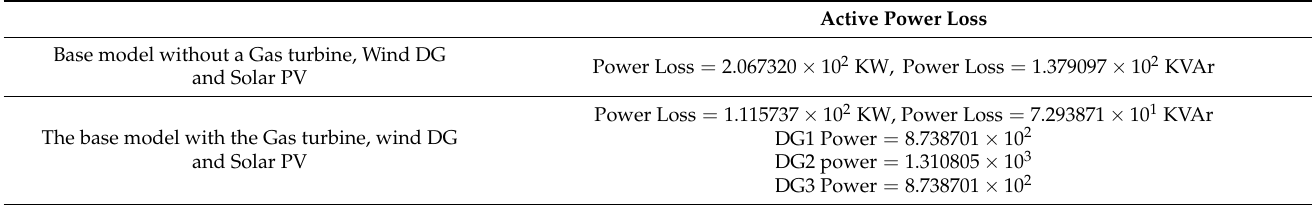
Table 6. Power loss comparison considering case study with DG and without